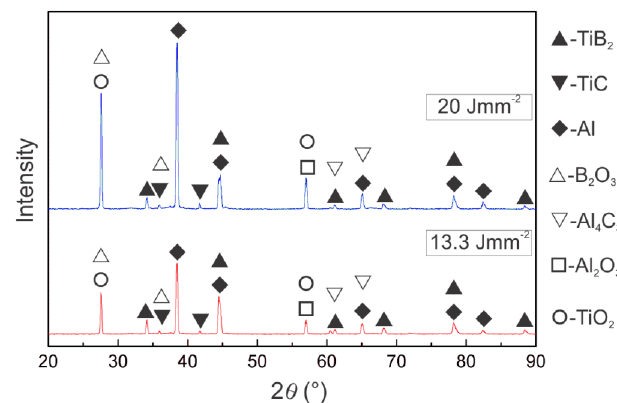
Figure 5. X-ray di ff raction (XRD) pattern of the coating produced using di ff erent Figure 5. X-ray diffraction (XRD) pattern of the coating produced using different LEDs.